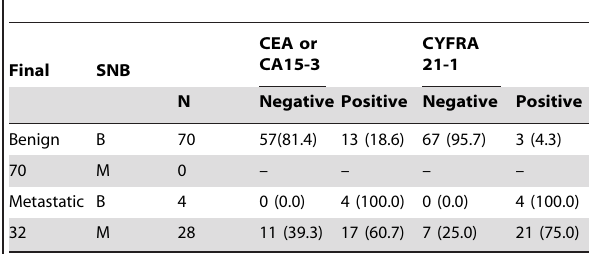
Table 3. Correlation of the 102 axillary LNs with sentinel node biopsy to concentrations of CEA, CA15-3 and